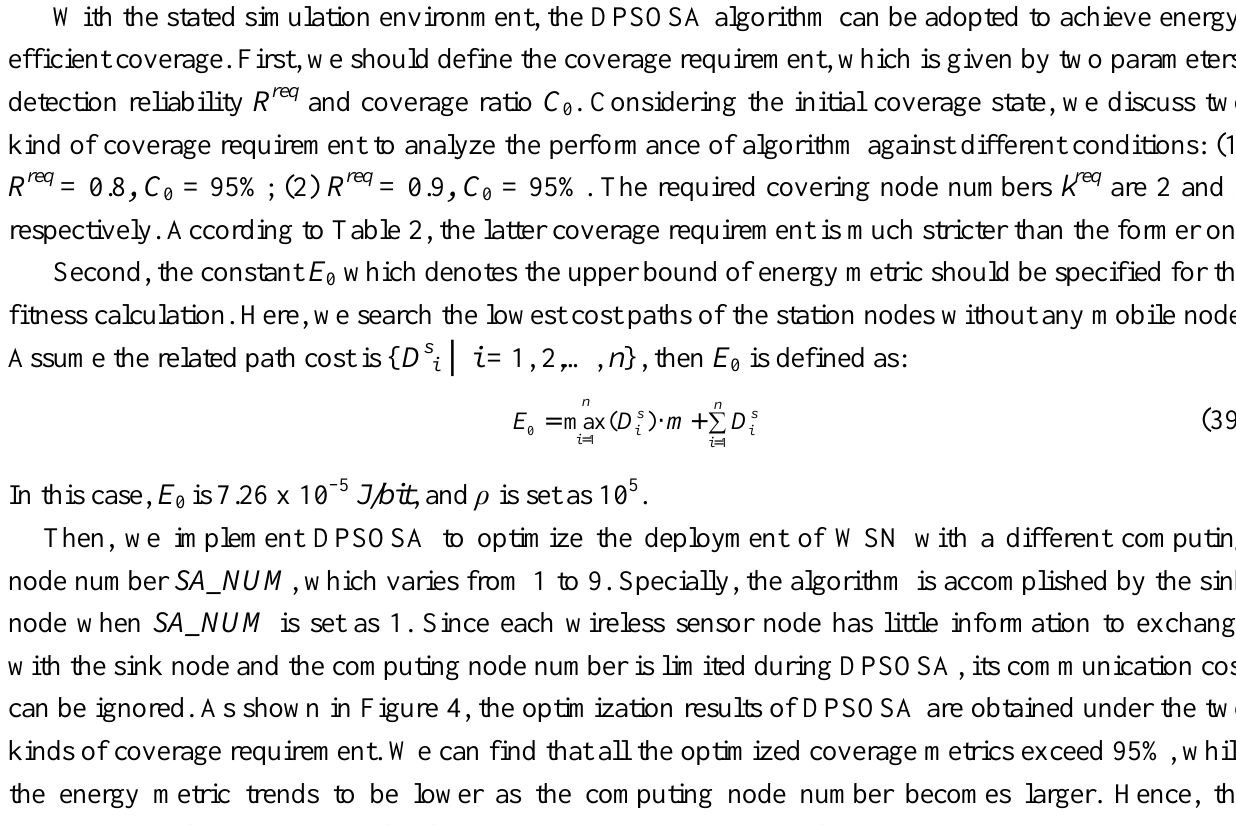
Figure 4. Optimization results of DPSOSA utilizing different computing node